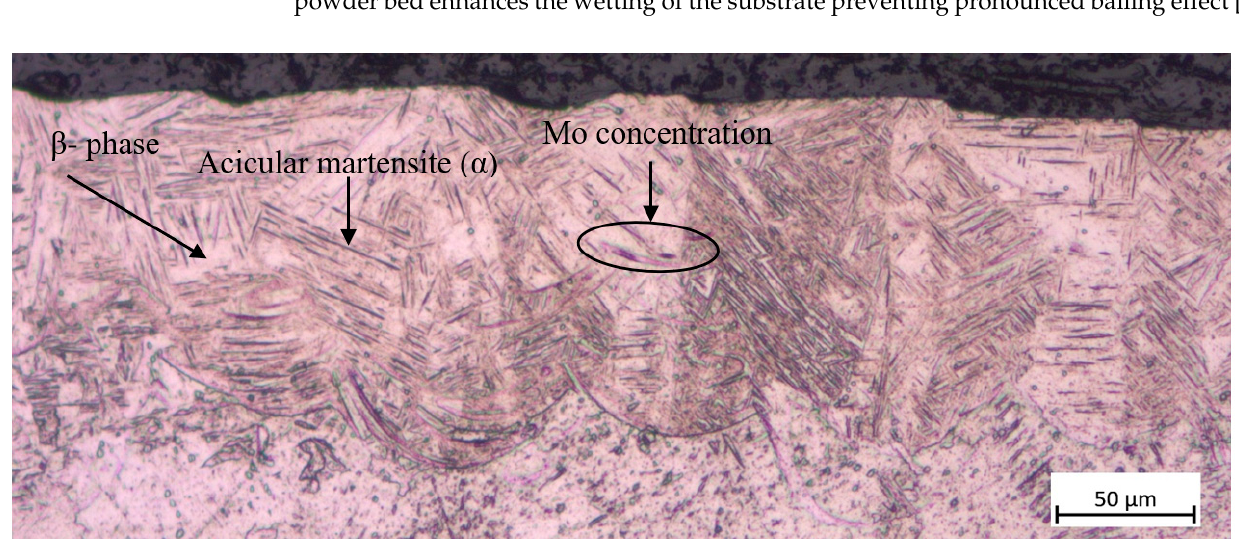
Figure 10. Solidification structure of the Ti5Mo alloy.